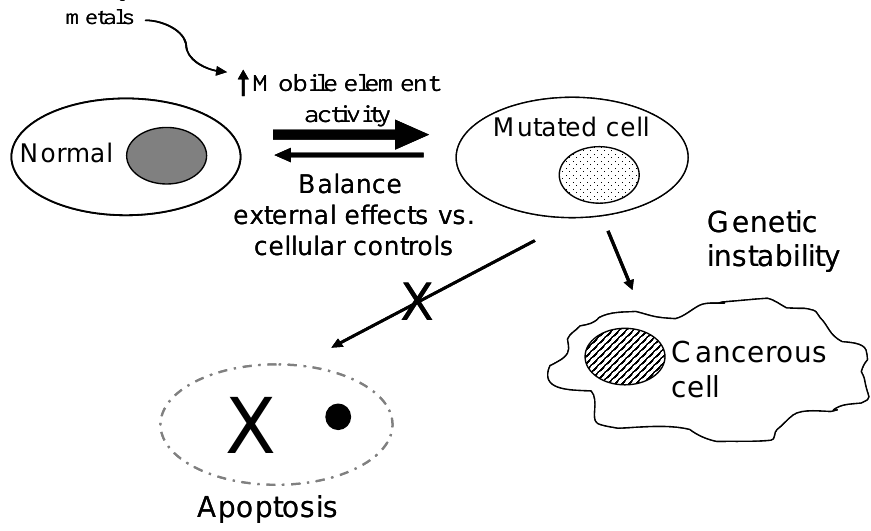
Figure 4: Proposed model for how metal stimulation of mobile elements may impact genetic stability. The balance between normal cells and altered or mutated cells is depicted as an equilibrium. External and internal components can affect the outcome of this equilibrium. Normal cells are consistently being mutated or altered by external factors, such as UV light, etc. The damage generated can be either repaired or progress to two outcomes: (1) Apoptosis to eliminate the damaged cell or (2) Disease/cancerous cell. We propose that heavy metals shift the equilibrium through the increase of retroelement activity potentially leading to the accumulation of more mutated